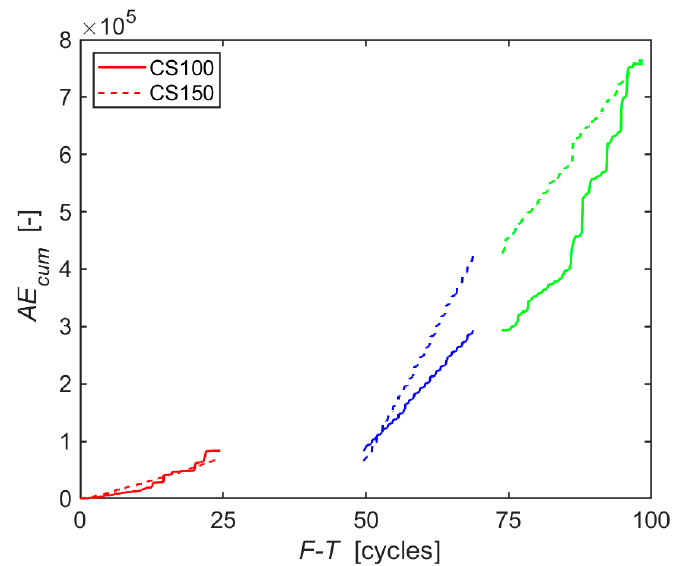
Figure 2. Cumulative number of AE counts during F-T cycles.